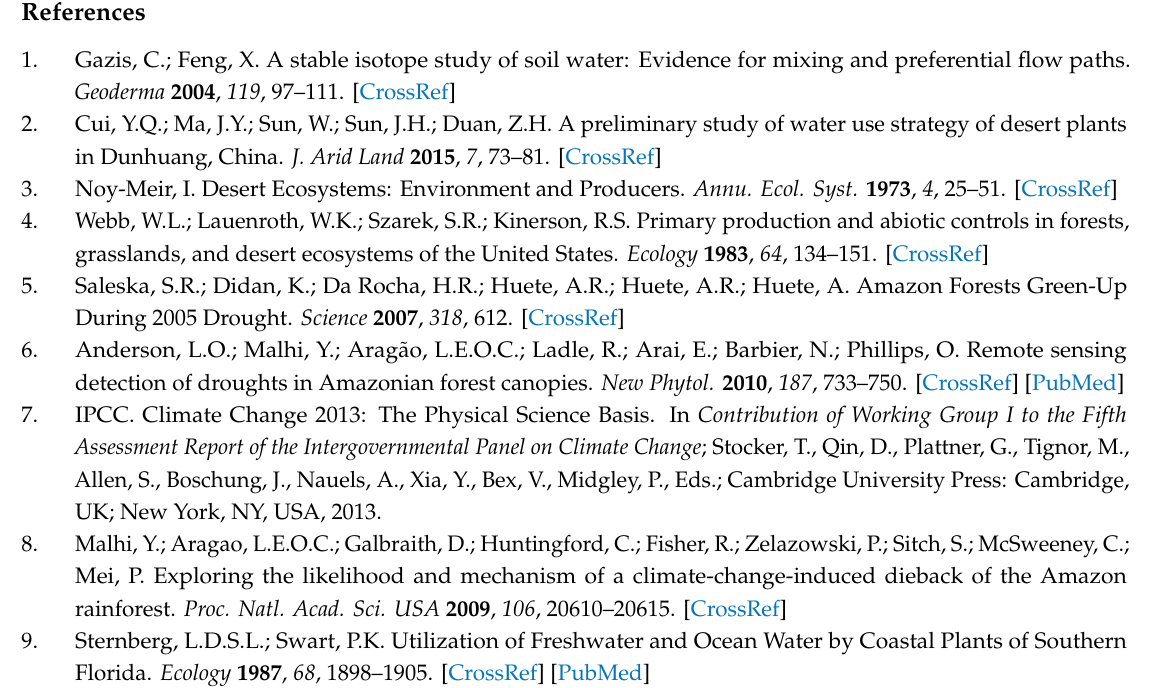
Table S1: Species-specific information on plant functional traits and water